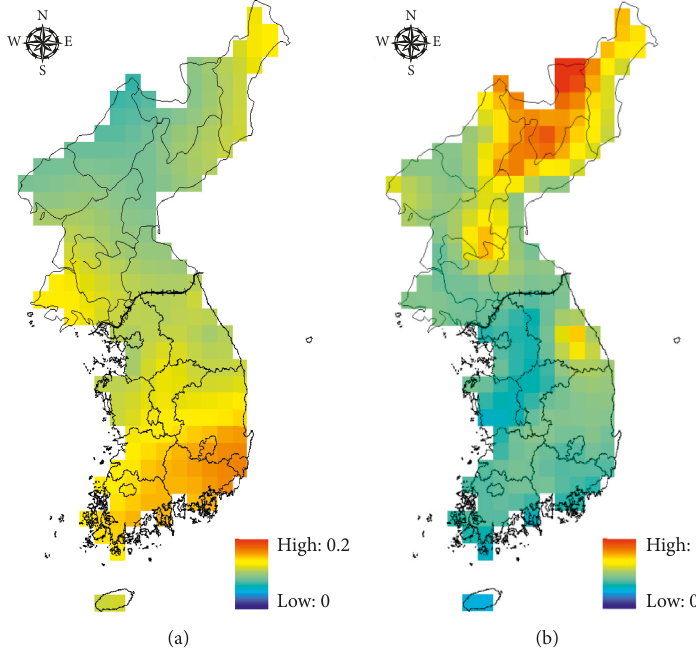
Figure 12: Coefficients of variation of 13 GCMs. (a) Precipitation. (b)